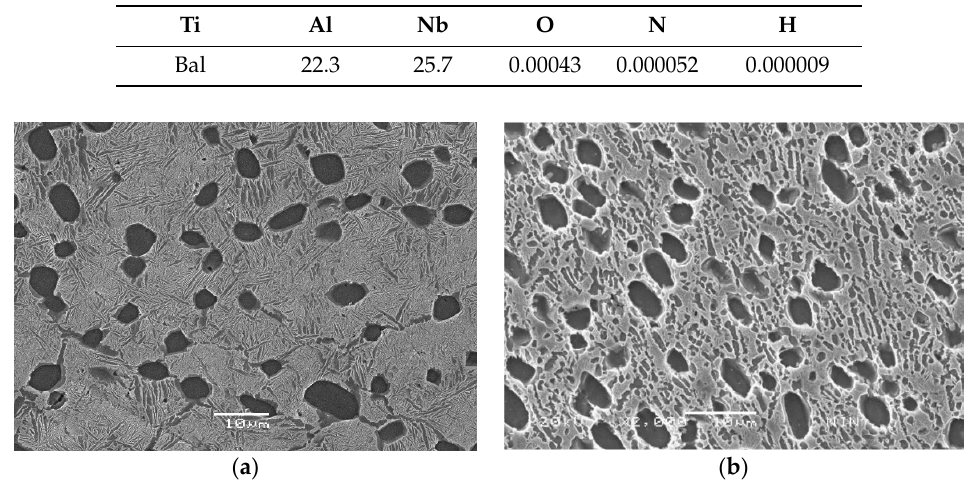
Figure 1. ( a ) Microstructure of the as-forged alloy bar; ( b ) microstructures of the isothermal forged bar in the α 2 + O+ B2 phase region (the black equiaxed particles are α 2 phases, the gray regions are O phases, and light regions are B2 phases).